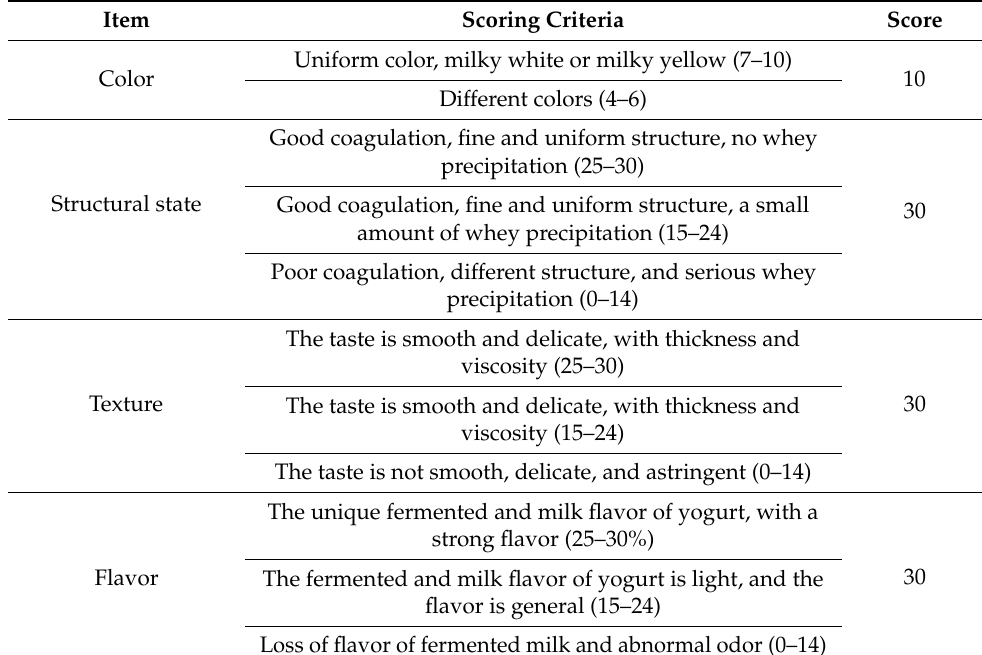
Table 2. Sensory score criteria of set-type